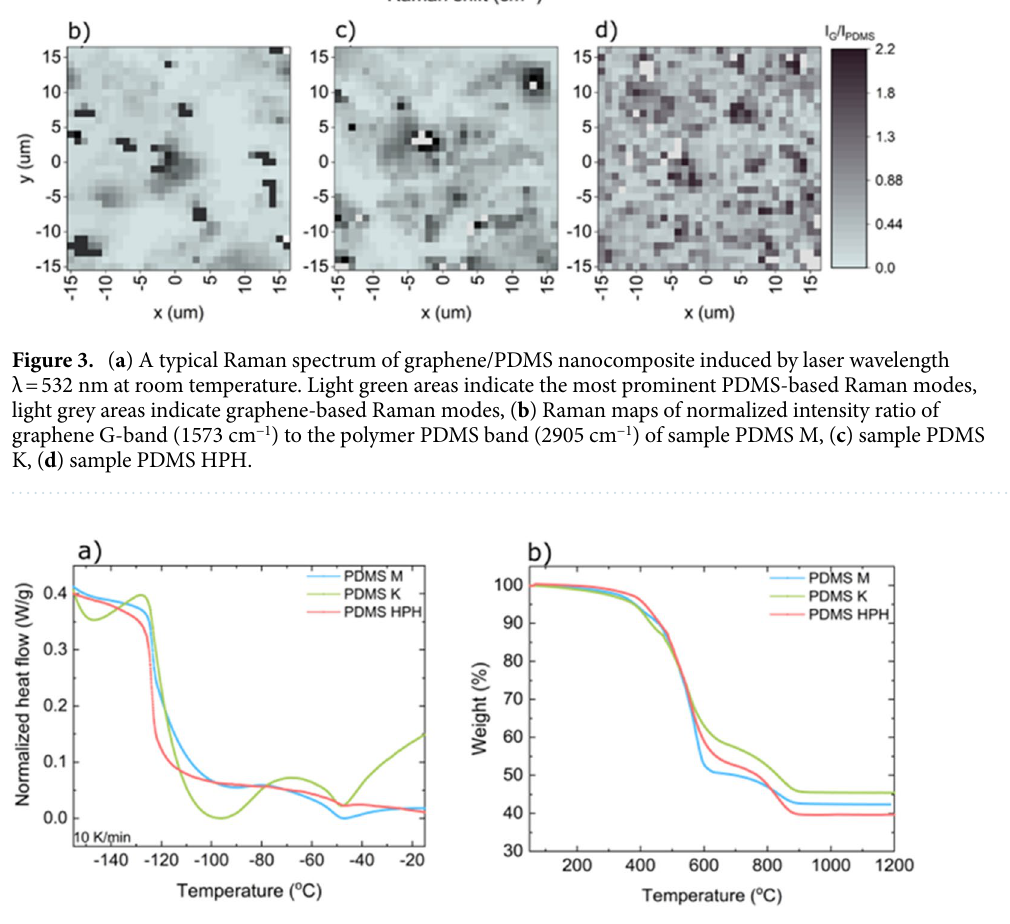
Figure 4. ( a ) DSC and ( b ) TGA thermograms of PDMS/10%wt graphene nanocomposite samples produced using different techniques: magnetic mixer stirring, calendaring and microfluidization.